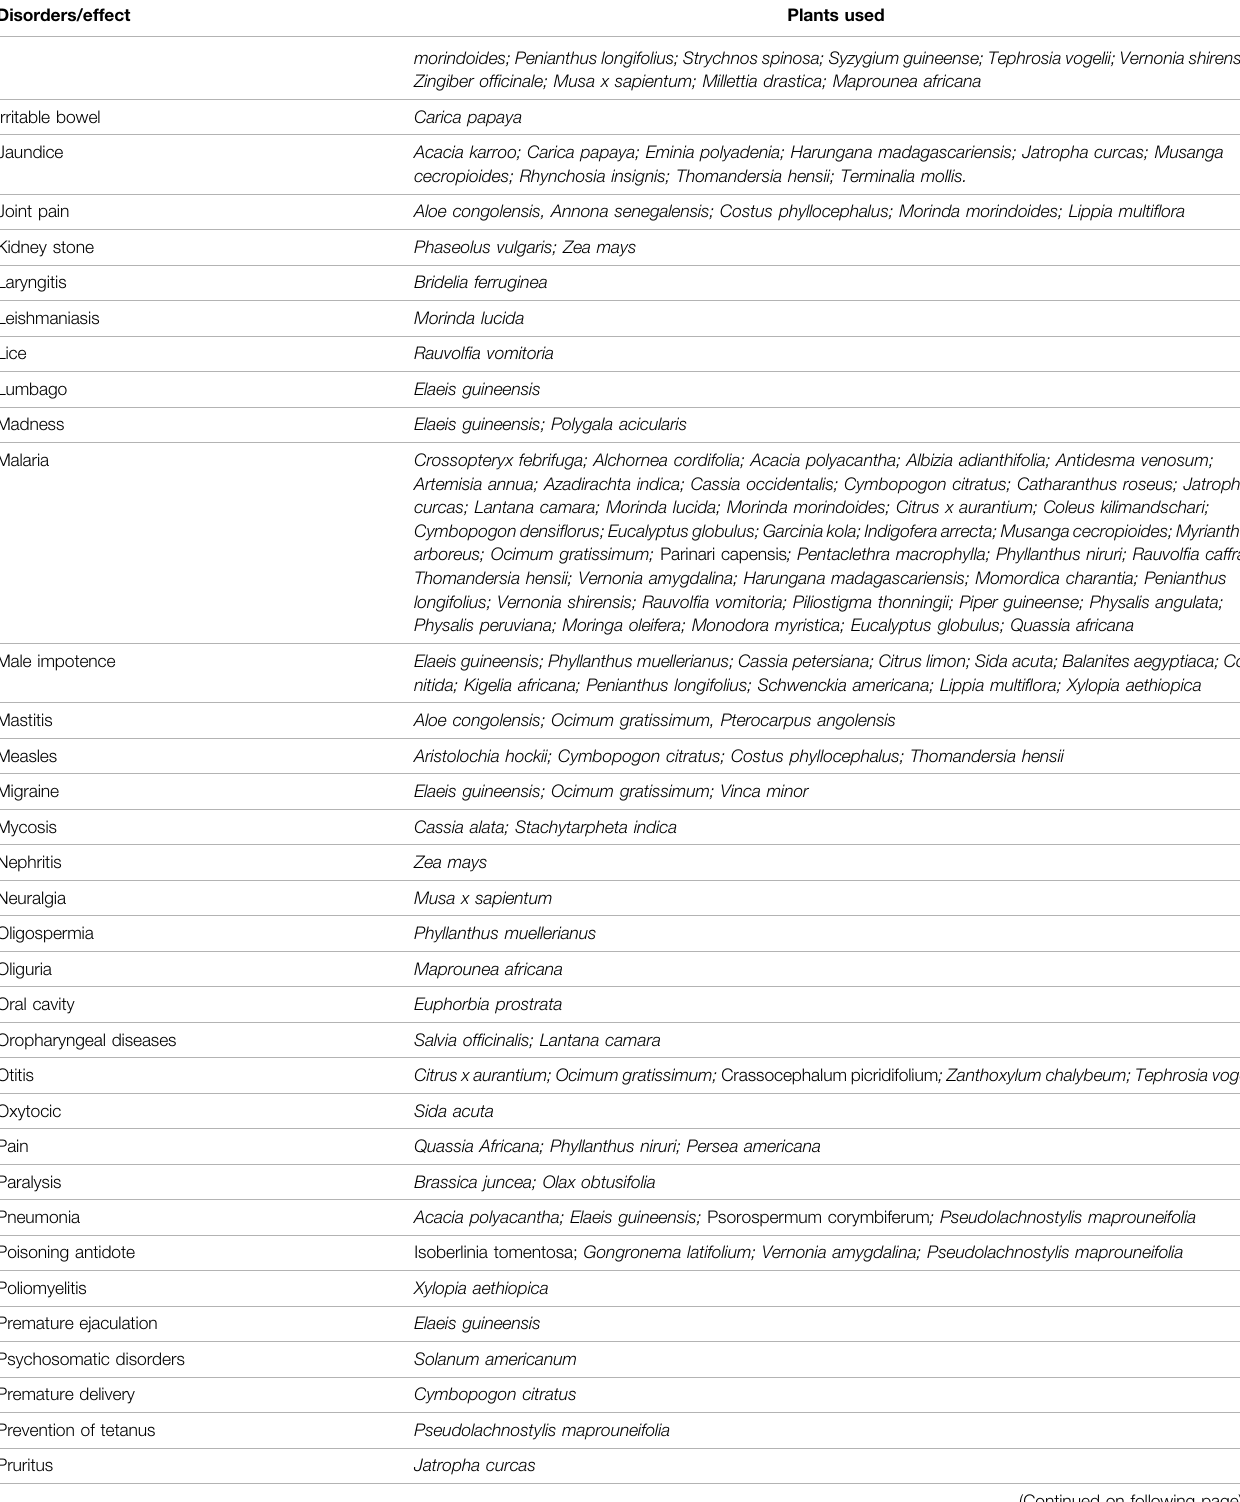
TABLE 3 | ( Continued ) Antidiabetic plants used locally for the treatment of other various